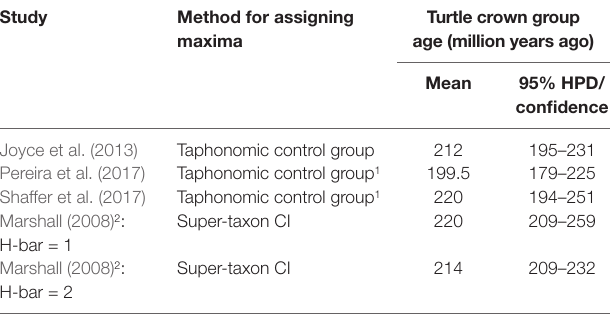
TABLE 3 | Taphonomic control group and super-taxon confidence interval approaches to estimating maximum (and minimum) age constraints on turtle divergence times are broadly congruent when they all use the same fossil FAD